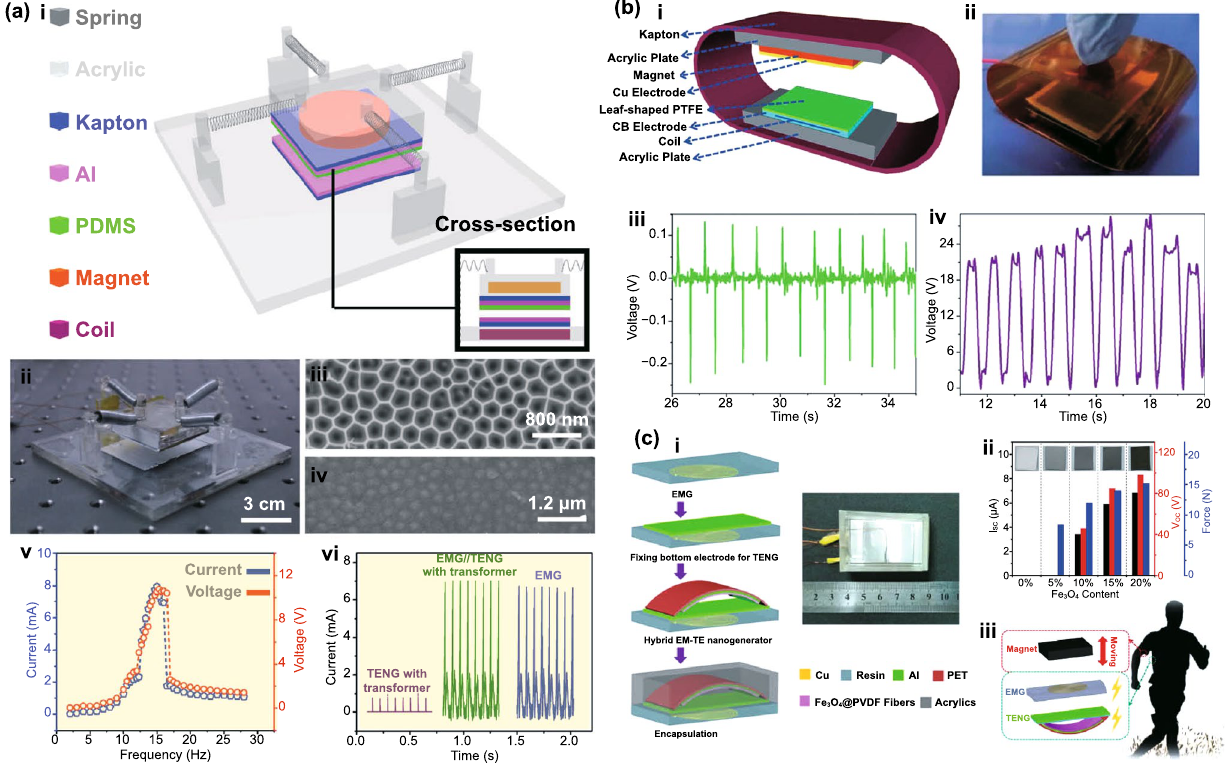
Fig. 21 a (i) Schematic diagram and (ii) photograph of the hybrid nanogenerator fabricated by Quan et al. SEM images of the (iii) anodic alu- minum oxide template and (iv) nanostructured PDMS film. (v) Frequency response of the output current and voltage for the EMG. (vi) Rectified output current of the TENG with transformer, EMG and hybrid nanogenerator with the EMG and TENG connected in parallel. Adapted from Ref. [92]. b (i) Schematic view and (ii) prototype of the hybrid EMG and TENG arc-shaped brace structure designed by Huang et al. Output OC voltage in response to a finger tapping for the (iii) EMG and (iv) TENG. Reproduced with permission from Ref. [93]. Copyright 2017, Crea- tive Commons Attribution 3.0 Unported Licence. c (i) Scheme and photograph of the non-contact encapsulated E-TENG hybrid nanogenerator designed by Ren et al. (ii) Fe 3 O 4 nanoparticles content dependence of the SC current, OC voltage and magnetic force on the PVDF/Al TENG. (iii) Schematic of the nanogenerator employed on a “self-powered coat” to harvest energy from human motions. Reproduced with permission from Ref. [94]. Copyright 2017, Elsevier Ltd. All rights reserved. (Color figure